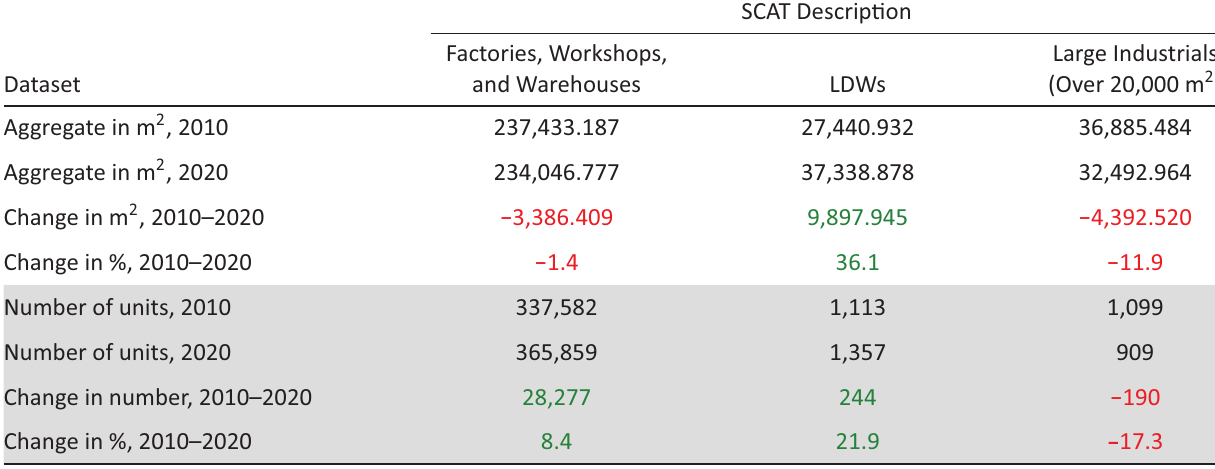
Table 1. Change in floorspace (m 2 ) and number of units by category,